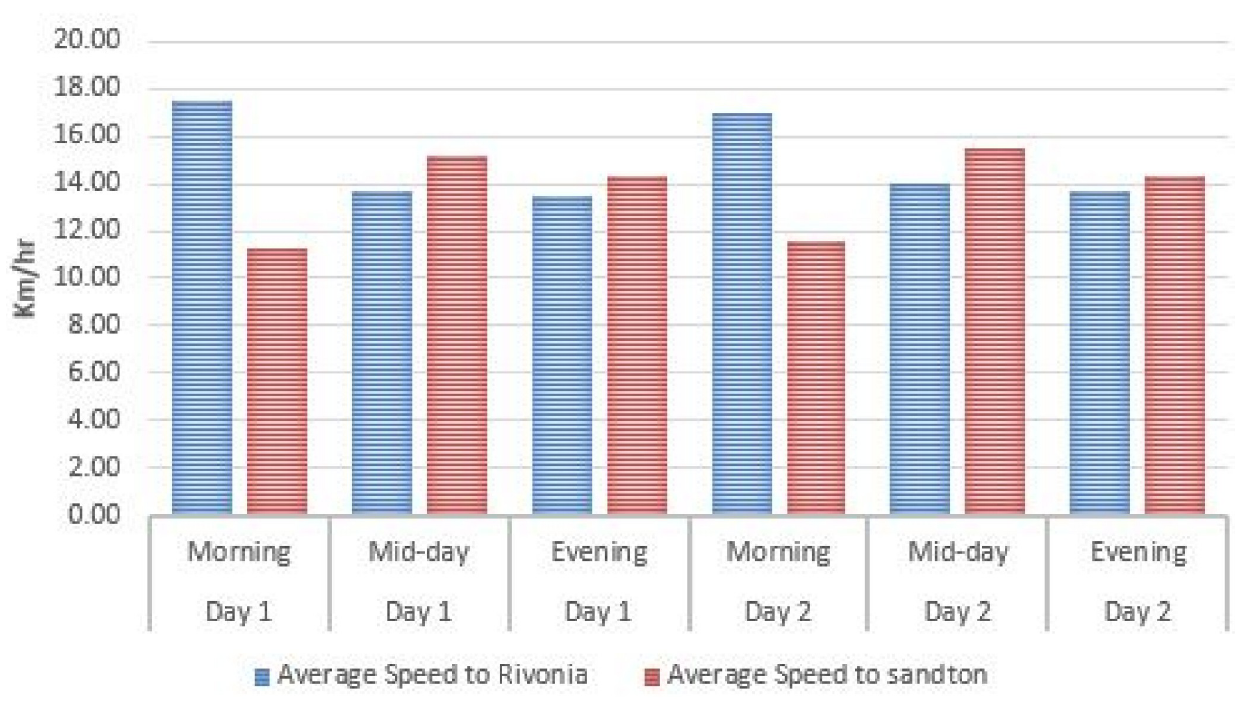
Fig 9. Average travel speed on the S3 Data Gaubus route near Sandton Gautrain station.